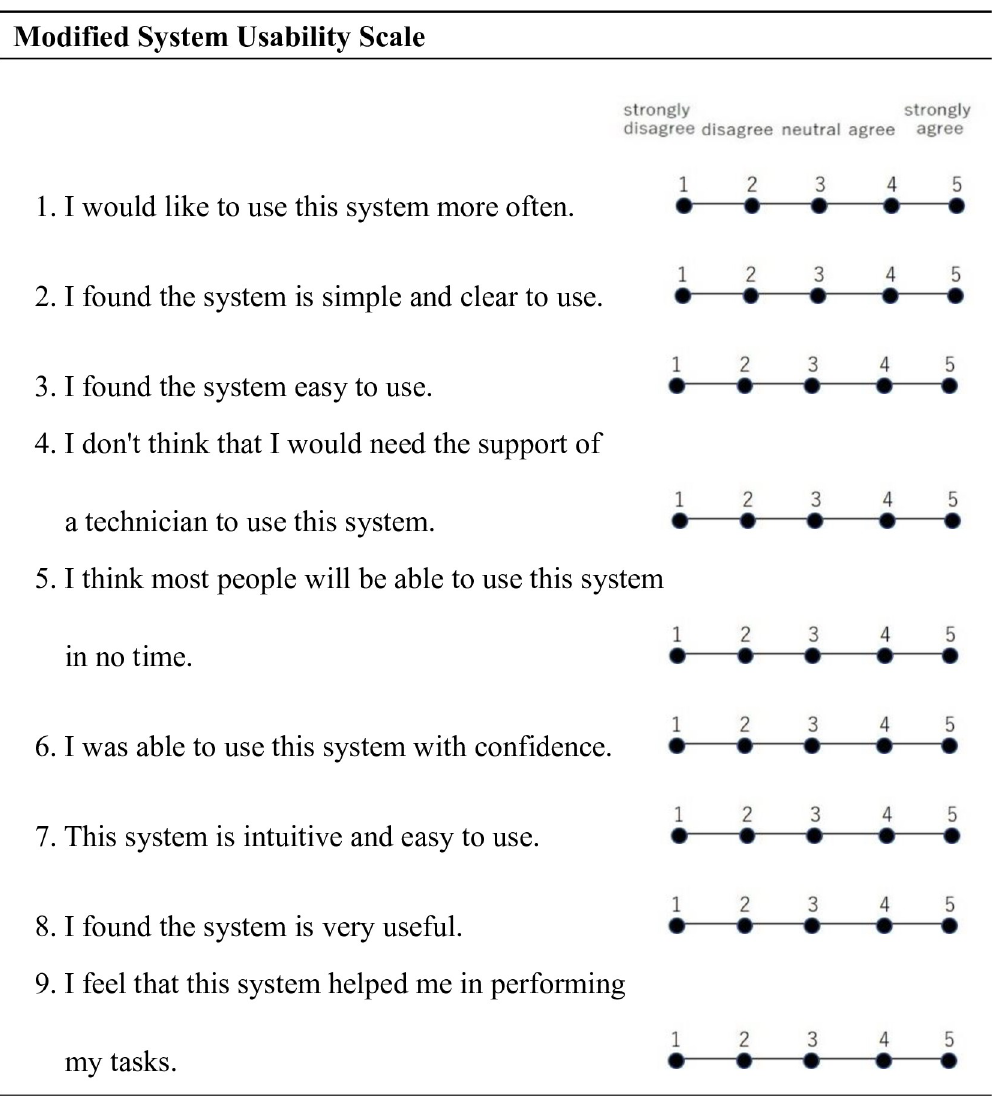
Fig 3. Modified System Usability